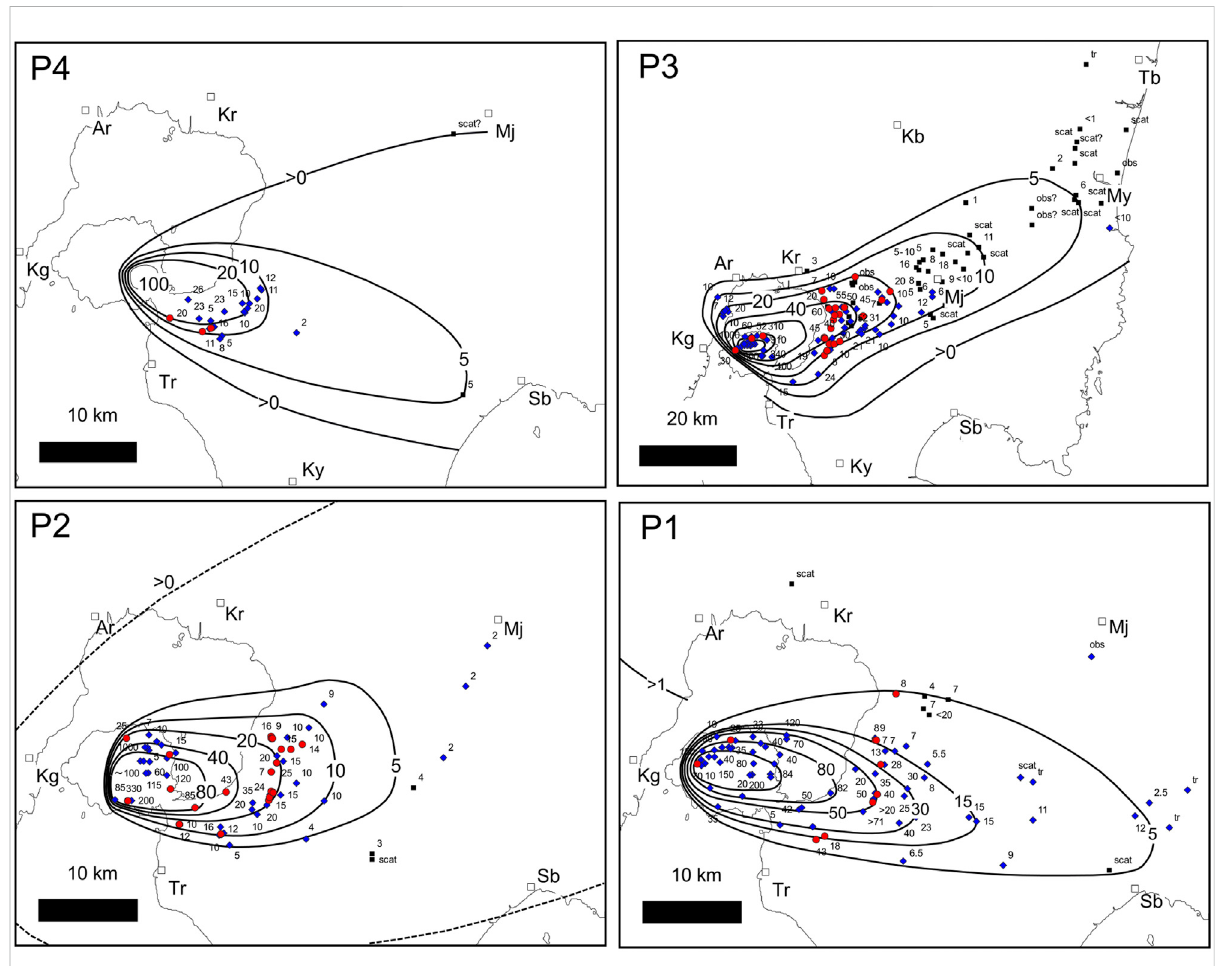
FIGURE 9 Distributions of the P4-P1 pumice fall deposits. Legend is the same in Figure 3A. The numbers of the thickness and isopach contours are describedincm.Solidwhitesquaresindicatethelocationofmajorcities,andtheabbreviationsarethefollowings:Ar,Airacity;Kg,Kagoshimacity;Kr, Kirishima city; Mj, Miyakonojo city; My, Miyazaki city; Sb, Shibushi city; Tr, Tarumizu city; Tb, Takanabe